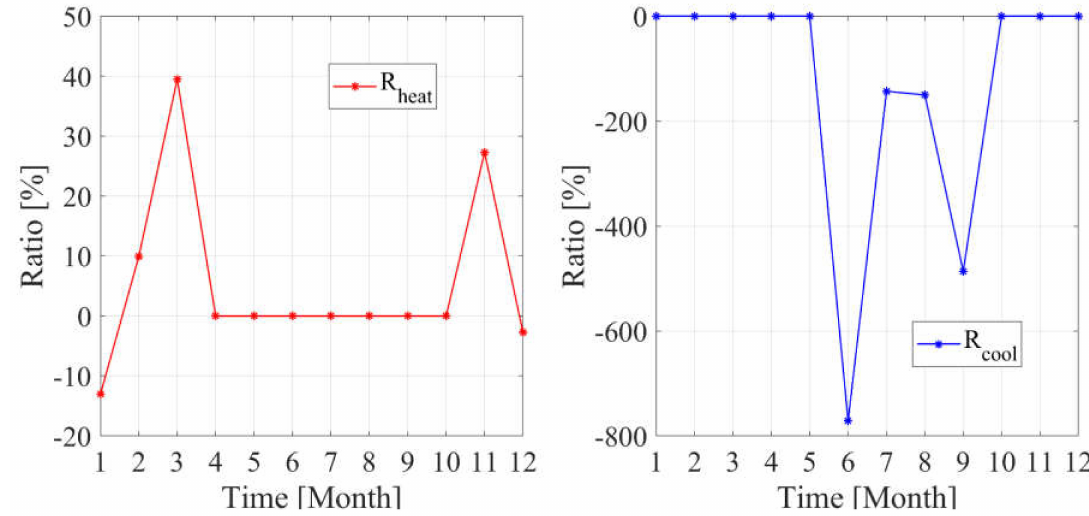
Figure 13. Monthly thermal energy